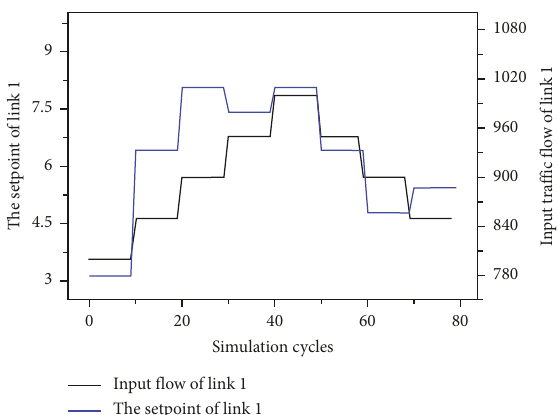
Figure 9: The optimization process of the set point of link 1 when � 1. N p